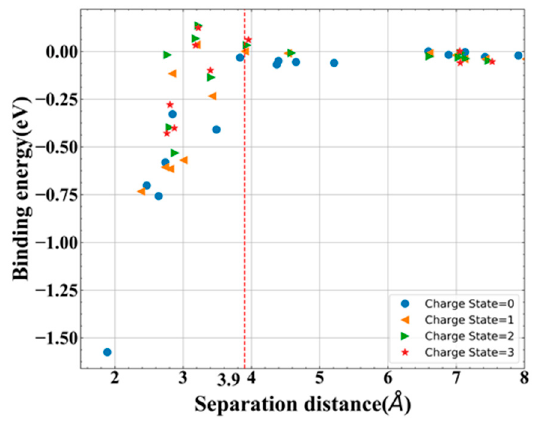
ff erent charge states of N i –V N as a function of d FP-sd